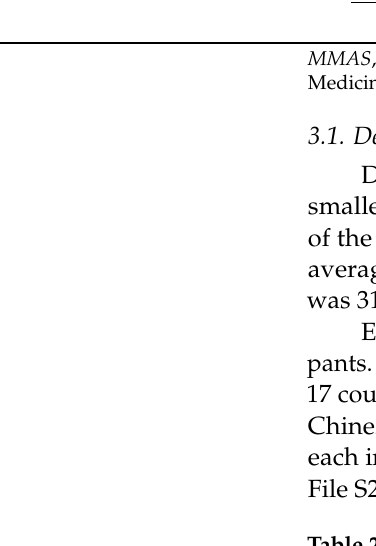
Table 2. Overview of general and demographic